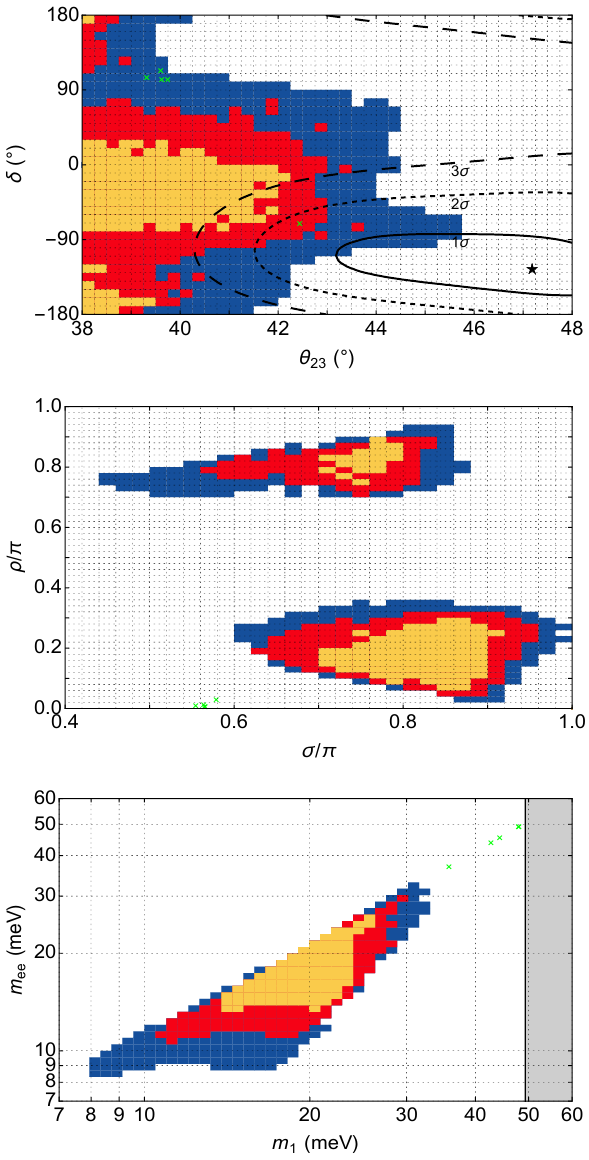
for (cid:11) 2 = 5 and three di(cid:11)erent values of B (cid:0) L